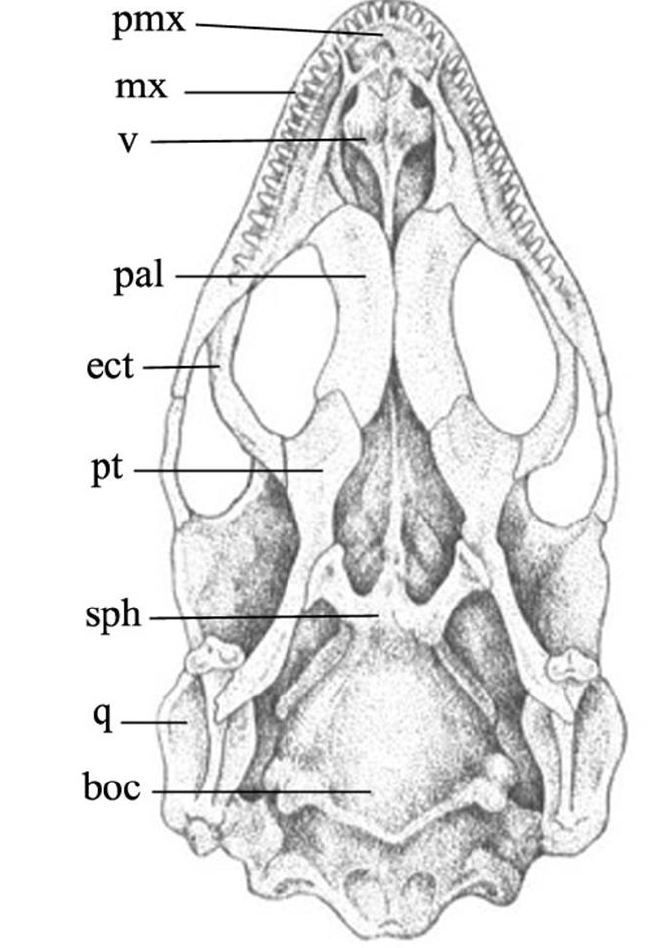
F IGURE 2. Ventral view of skull of Ablepharus kitaibelii . Abbreviations: boc, basioccipital; ect, ectopterygoid; mx, maxilla; pal, palatine; pmx, premaxilla; pt, pterygoid; q, quadrate; sph, sphenoid; v, vomer (modified from Fühn,